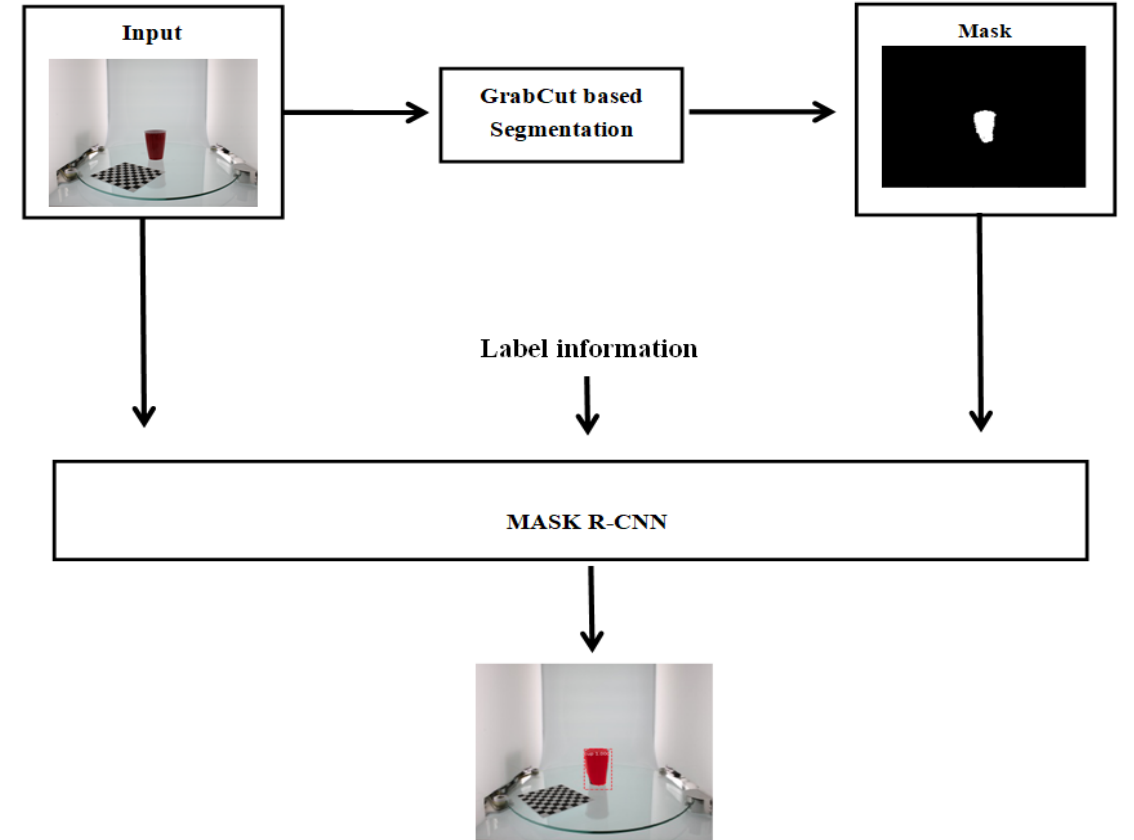
Figure 2. Automated method for generating the image mask.